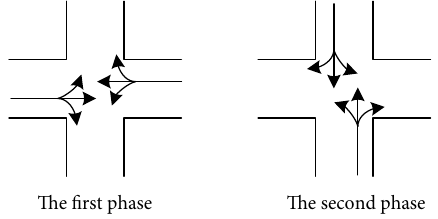
Figure 1: Phase diagram of traffic